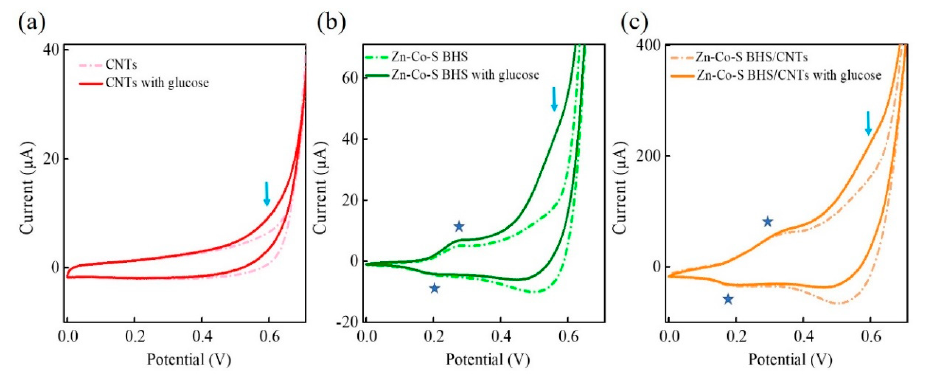
Figure 4. CV curves of ( a ) CNTs, ( b ) Zn-Co-S BHS, and ( c ) Zn-Co-S BHS/CNTs in 0.1 M NaOH in the absence (dashed lines) and presence (solid lines) of 1.0 mM glucose at a scan rate of 20 mV s − 1 .